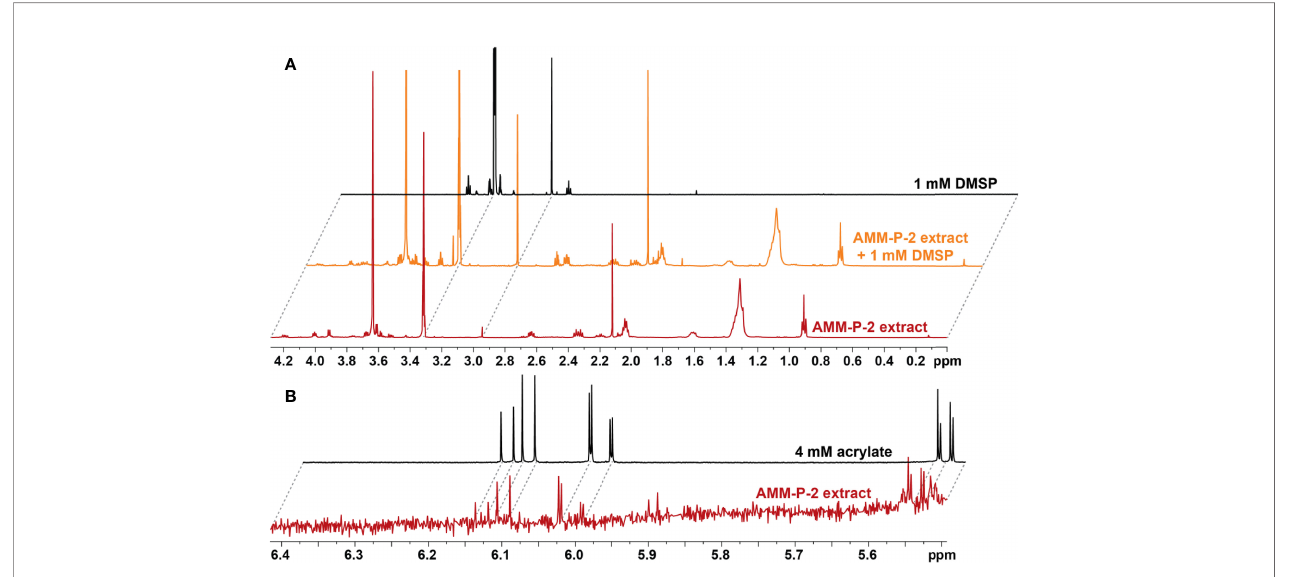
FIGURE 2 | Isolates harbouring dsyB produce dimethylsulfoniopropionate (DMSP). (A) 1 H NMR spectra of the DMSP region identifying diagnostic peaks ( d H 2.95 ppm) in deuterated methanol (CD 3 OD) extract of Shimia AMM-P-2 cultured in methionine-enriched minimal basal medium; the same Shimia AMM-P-2 cell extract